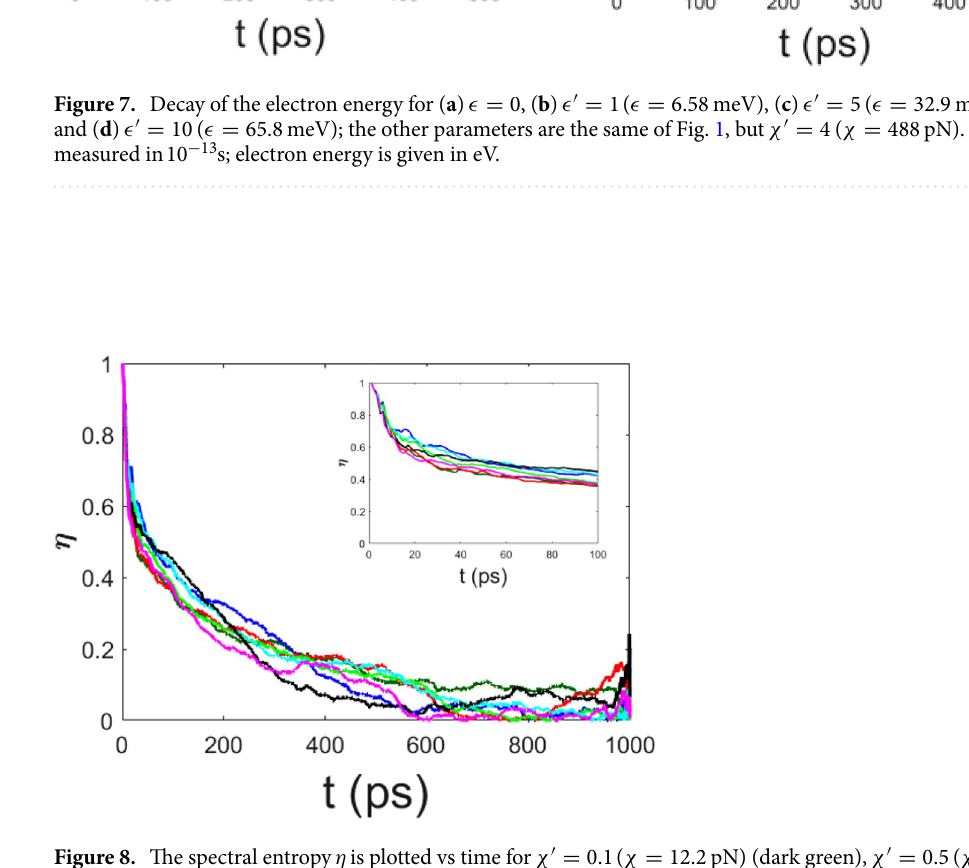
0.5 ( χ 61 ′ = = 3 ( χ 366 pN) (light ′ = =